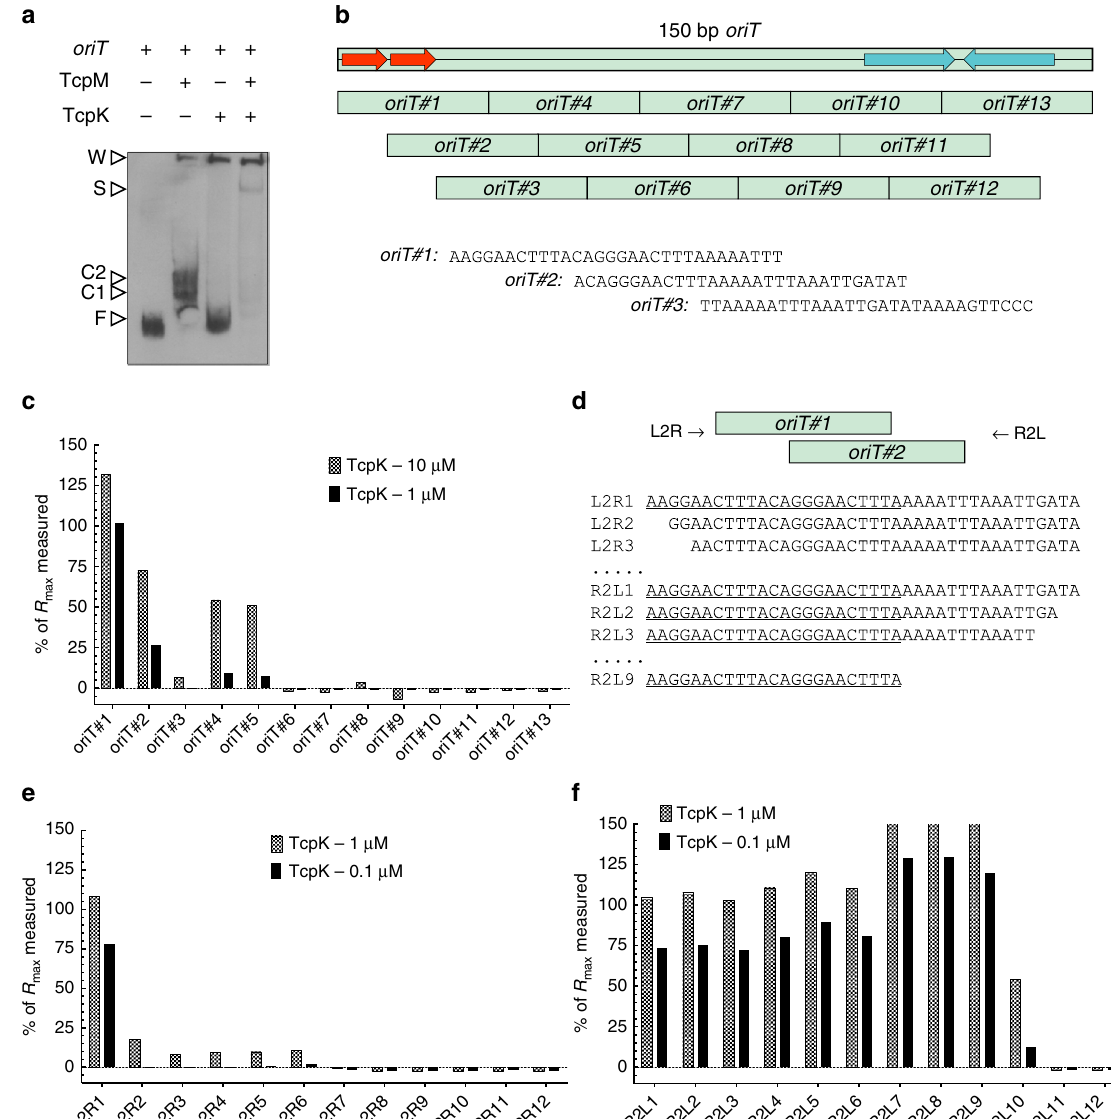
Fig. 2 Identi fi cation of TcpK binding site. a Gel mobility shift assays with His 6 -TcpK. The DIG-labeled 150 bp oriT fragment was incubated alone, in the presence of 450 nM TcpM, in the presence of 750 nM TcpK or in the presence of 450 nM TcpM and TcpK (50 nM), as indicated. Reactions were separated on a 6% (w v − 1 ) TBE acrylamide gel for 60 min at 200 V at 4 °C. Open arrows indicate free DNA (F), protein – DNA complexes (C), protein – DNA super-shifted complexes (S) and complexes in the wells (W). b SPR analysis of TcpK binding to oriT . The 150 bp oriT site of pCW3 was divided into overlapping fragments ( oriT#1 – oriT#13 ) each comprised of 30 bp with 20 bases overlap from one fragment to the next. The biotinylated single-stranded DNA (ssDNA) ReDCaT linker was immobilized on the surface of a Streptavidin (SA) chip to a surface density of 450 Resonance Unit (RU). c The binding of TcpK to the oligonucleotides was tested by SPR at protein concentrations of 10 μ M (checked bars) and 1 μ M (solid bars). The binding levels are expressed as a percentage of the theoretical maximum response (see Methods). d SPR-based mapping de fi nes the TcpK binding site. A 39 bp fragment that encompassed oriT#1 and oriT#2 was used as the initial test fragment (L2R1 and R2L1 for left to right and right to left, respectively). Subsequent oligonucleotides (L2R2 to L2R12 and R2L2 to R2L12) were incrementally shorter by 2 nt. TcpK binding to each oligonucleotide L2R ( e ) and R2L ( f ) was tested at protein concentrations of 1 μ M (checked bars) and 0.1 μ M (solid bars). The binding levels are expressed as a percentage of the